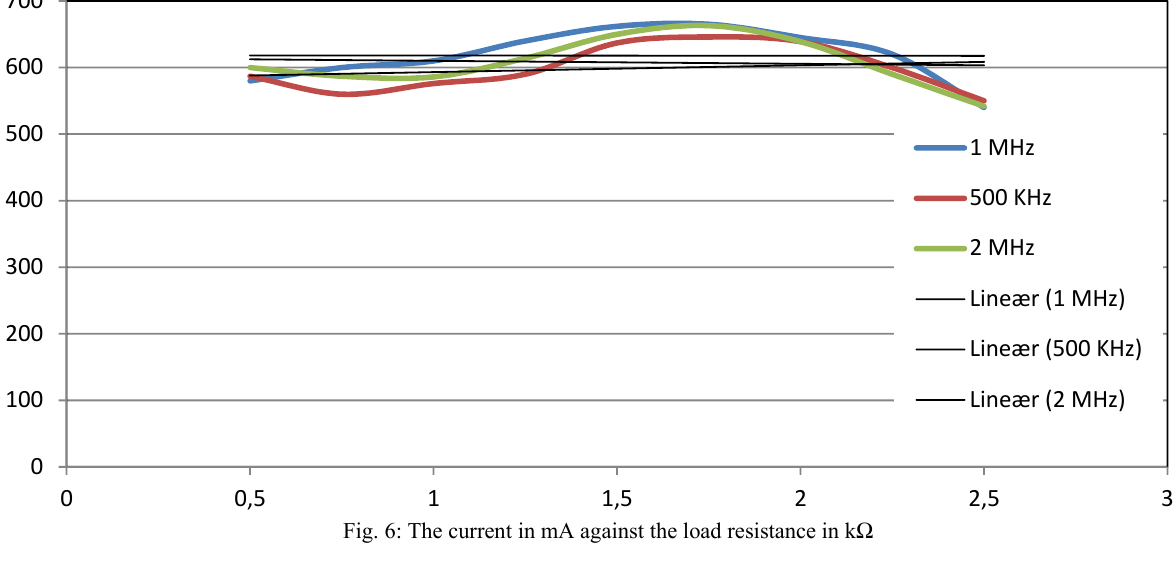
Fig. 6: The current in mA against the load resistance in k Ω